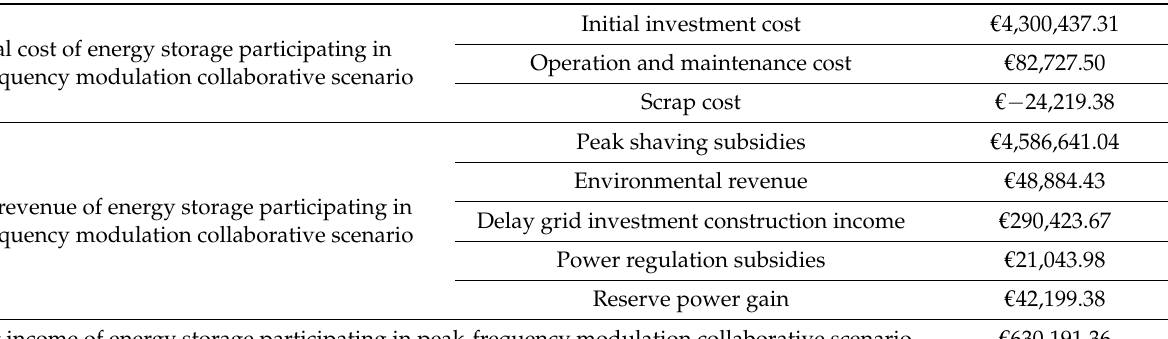
Table 9. Annual costs and benefits of energy storage in collaborative scenario of peak and frequency modulation. Annual cost of energy storage participating in peak-frequency modulation collaborative